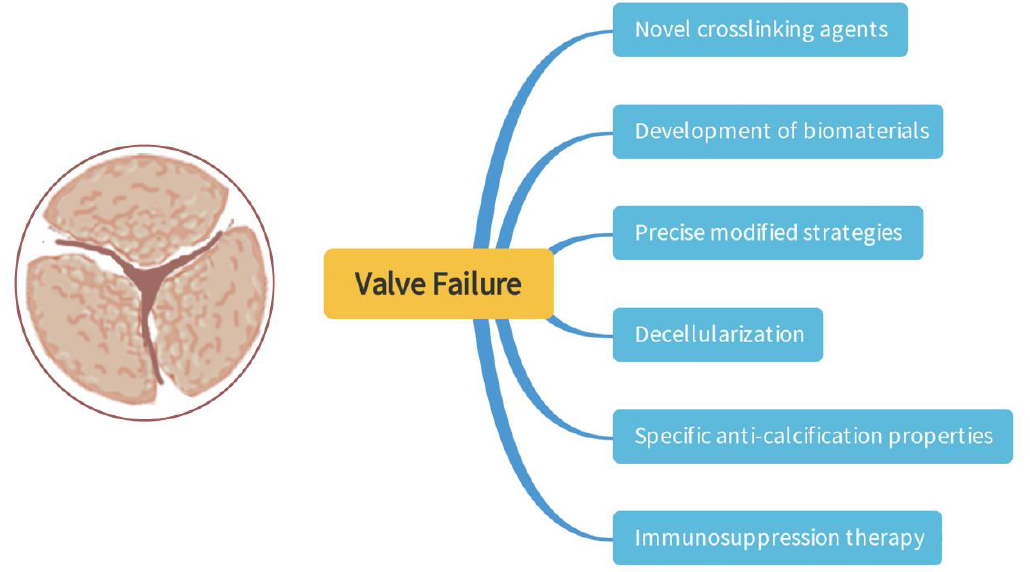
Figure 5. Key factors of TEHV development and strategies to retard TEHV.